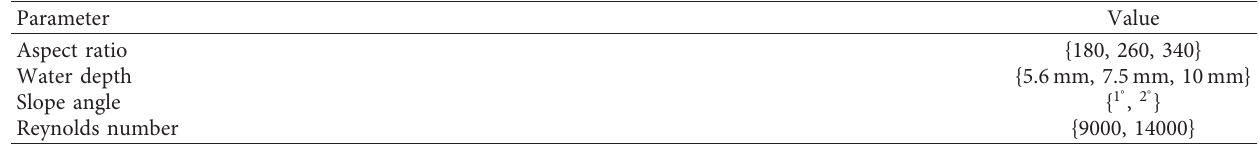
Figure 1: (a) Computational model of thin-layer cascade reactor inclined at 1 ° ; (b) sketch of the channel of the reactor. The coloured surface shows the liquid surface parallel to the wall and inclined by an angle with respect to the horizontal dashed surface. Table 1: Summary of important parameters of the thin-layer cascade